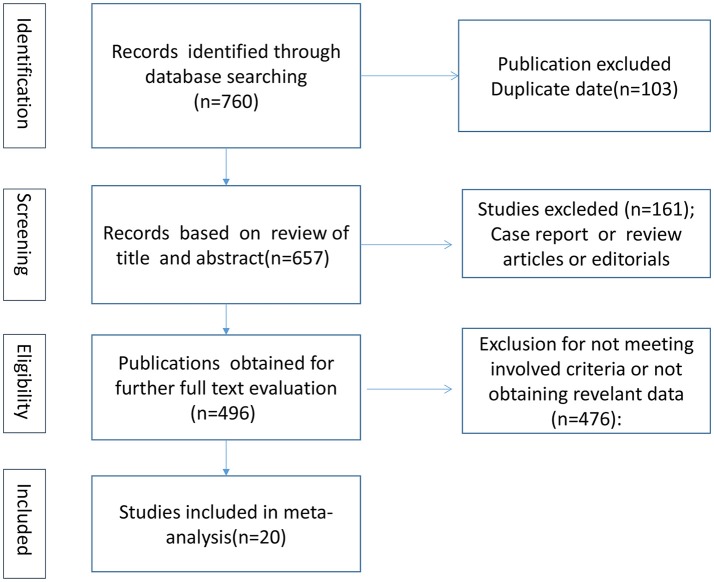
Flow diagram of search process and identified studies.